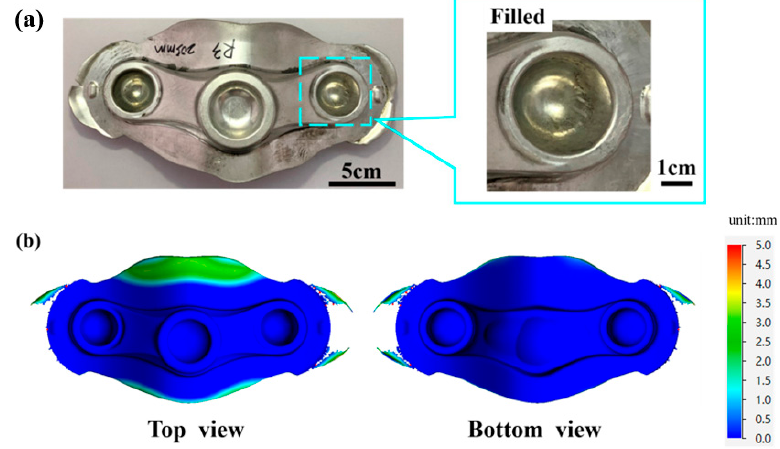
Figure 10. Improved crown-forging workpiece. ( a ) Top view of crown-forged products; ( b ) top view of simulation diagram of crown products.